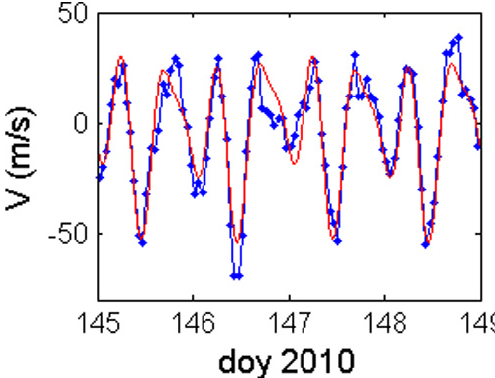
Fig. 4. An example of a four-component non-linear least-squares fit (red) to 4 days of hourly mean meridional wind (blue) during a period of strong semidiurnal